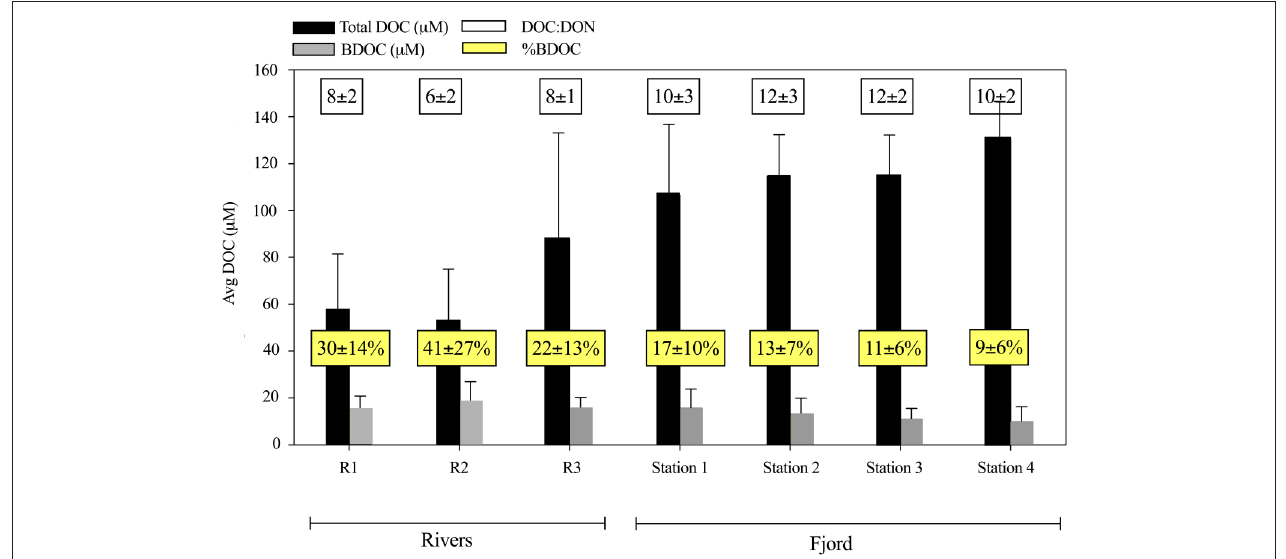
FIGURE 6 | The concentration of dissolved organic matter (DOC) (black) and the bioavailable dissolved organic matter (BDOC) (gray) in µ M ± SD for the three rivers ( n = 3) and the 4 fjord stations average including both 1m and DCM ( n = 8–10). White boxes present the averaged DOC:DON ratio of the organic matter. Yellow boxes present the BDOC percentage of the total DOC